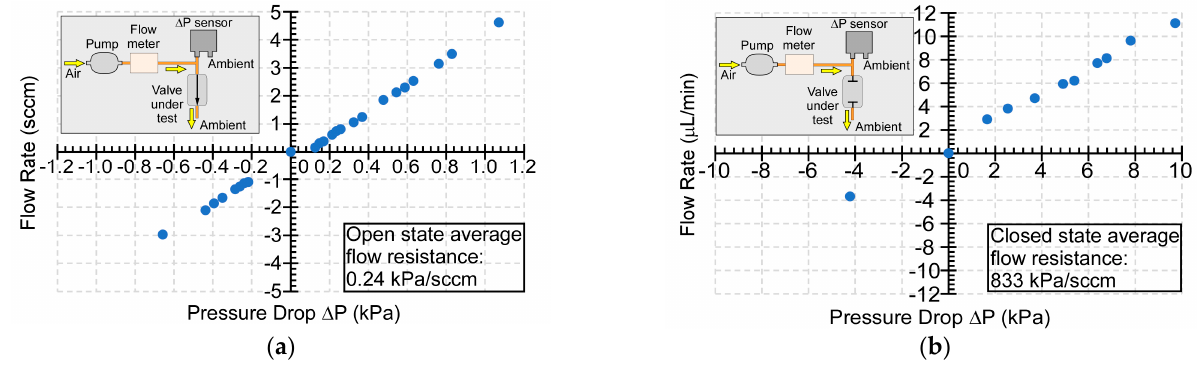
Figure 8. ( a ) Flow characteristics for an open microvalve. ( b ) Leakage characteristics for a closed microvalve. The test setup for each case is shown in the insets.